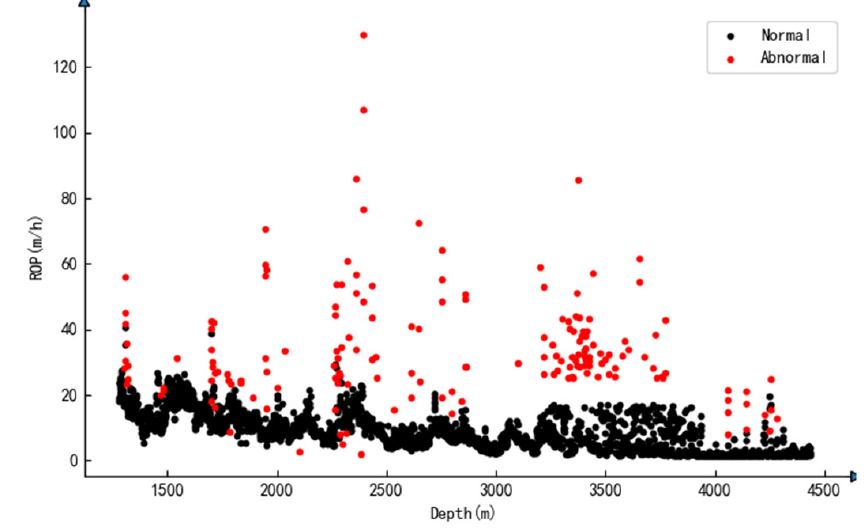
Figure 8. The result of abnormal data detection.